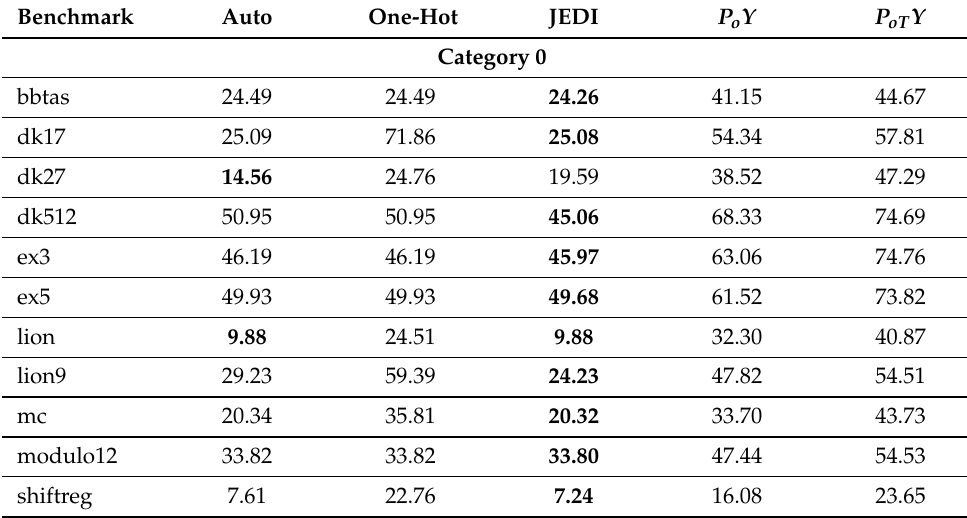
Table 18. Experimental results [132] (area-time products, LUTs × ns ).